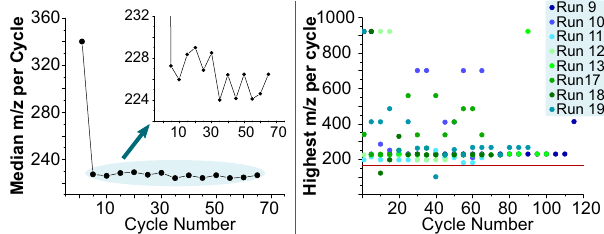
Fig. 6 Experiments compared by the highest m/z value. On the left, we present a diagram, which shows the median of the highest m/z value of each experiment compared with the cycle number. As the fi rst value is very high, a zoomed-in version of the plot is shown as an inset. On the right, we show the highest m/z value over the threshold of each cycle of selected runs. The line (red) in the plot represents the m/z value of the heaviest